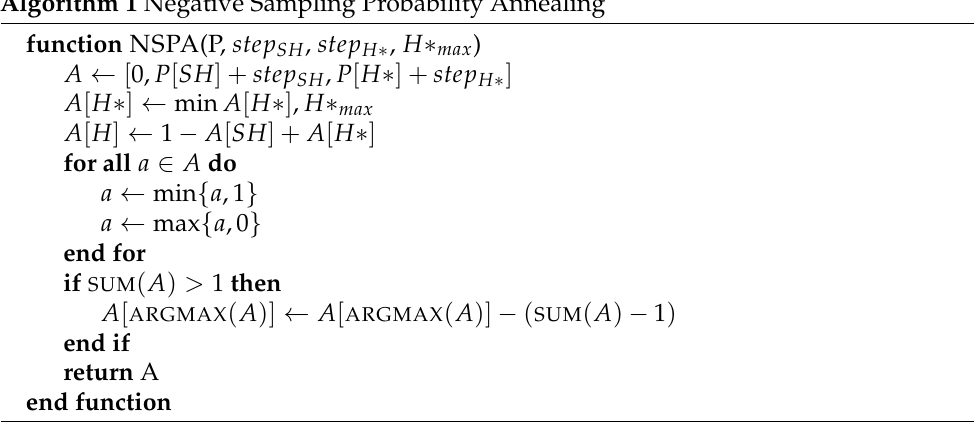
Algorithm 1 Negative Sampling Probability